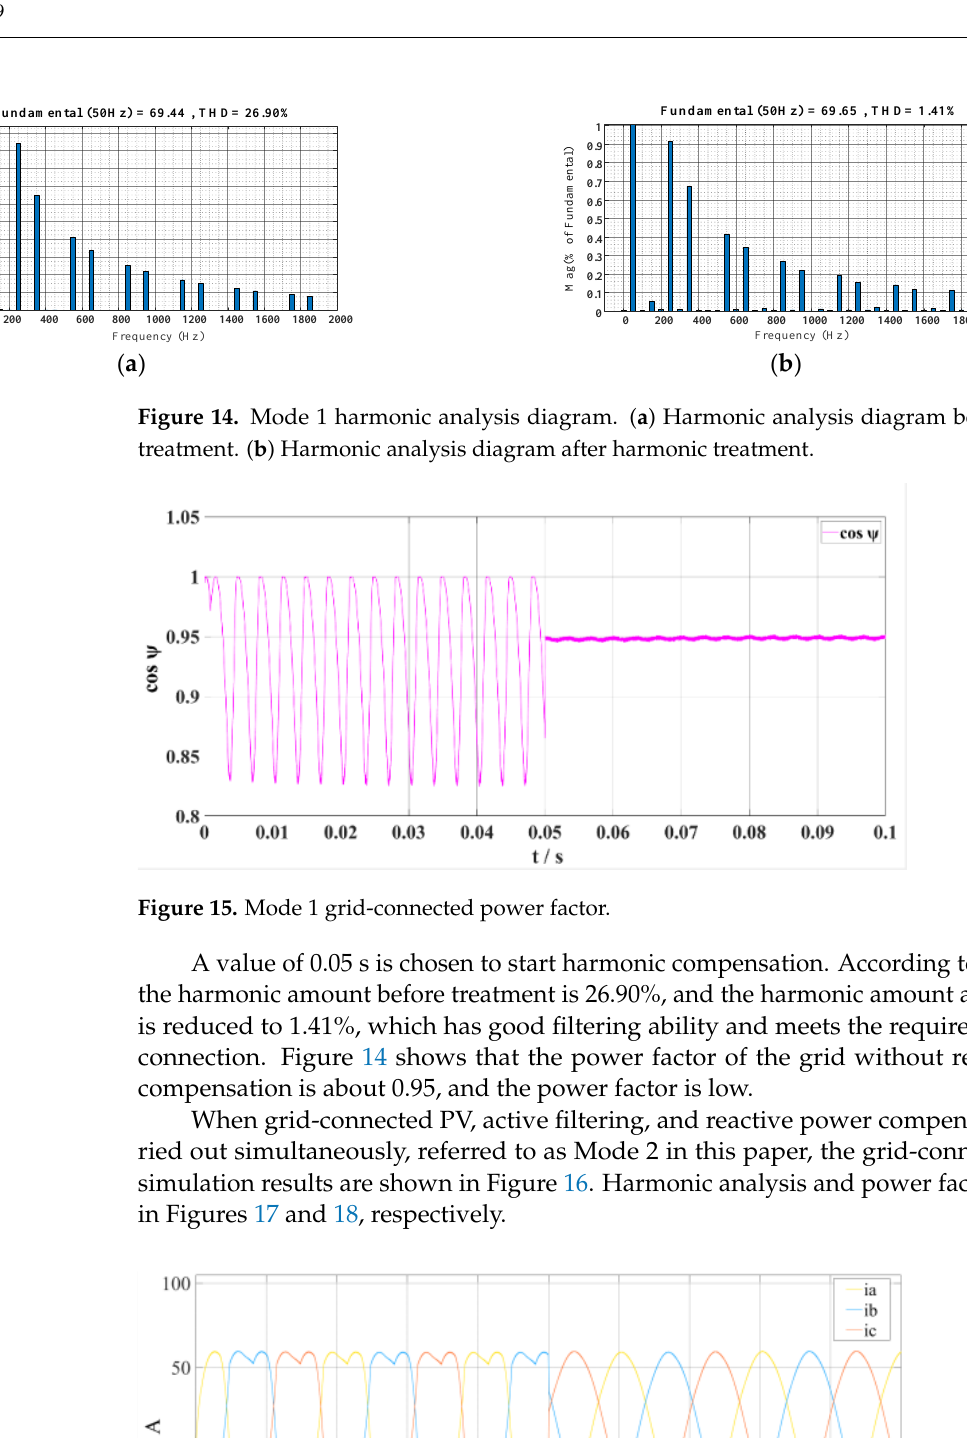
Figure 16. Mode 2 grid current diagram.